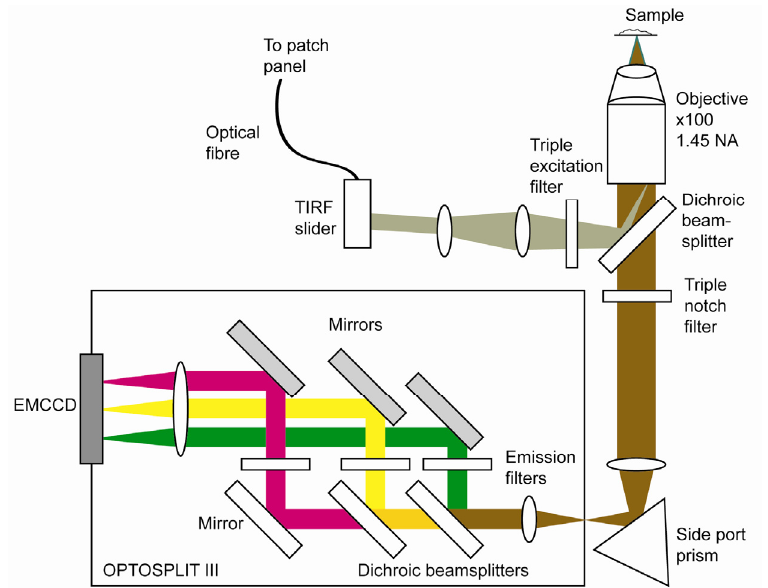
Figure 4. Schematic view of a microscope set up for 3-colour single molecule TIRF